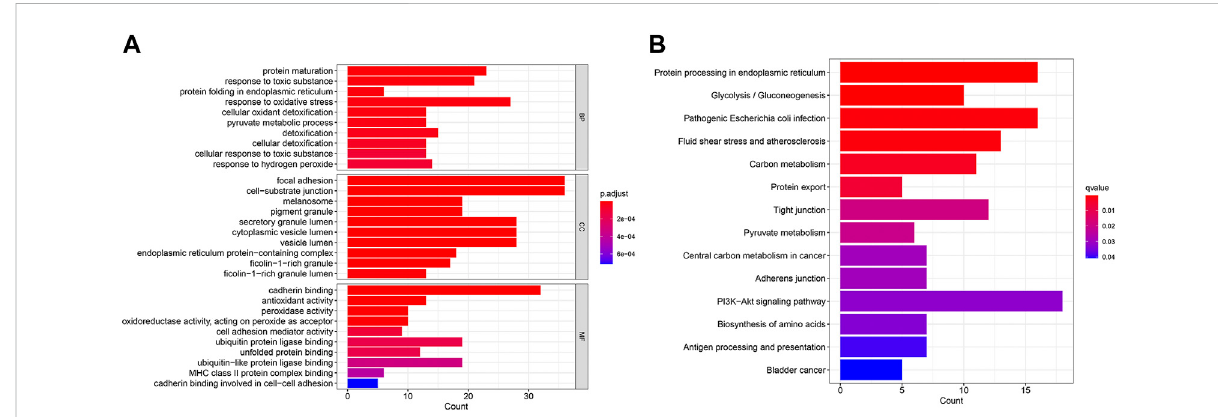
FIGURE 5 GO enrichment analysis (A) and KEGG enrichment analysis (B) of CDRG. (A) The results of GO enrichment analysis showed that these genes were mainly related to protein processing and maturation (B) The results of the KEGG enrichment analysis showed that these genes were mainly related to glycolysis and sugar metabolism and protein processing, and transport.